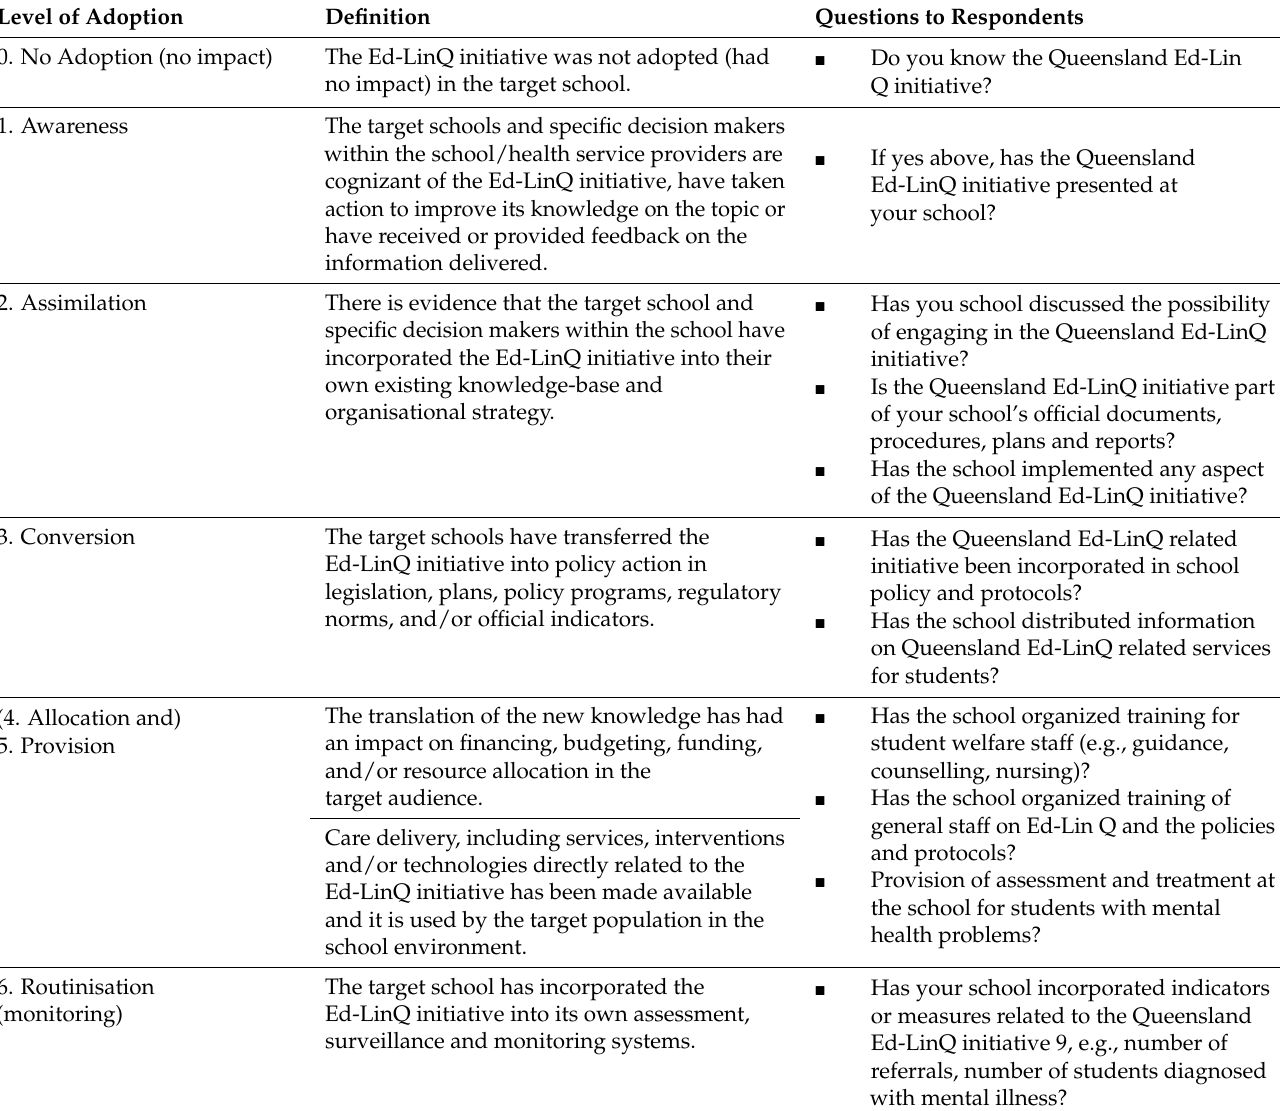
Table 1. Adoption Impact Ladder (AIL) adapted for the assessment of the Ed-LinQ initiative. The Allocation and Provision levels of the AIL were merged for the analysis of this initiative into a single level (Level 5). Level of